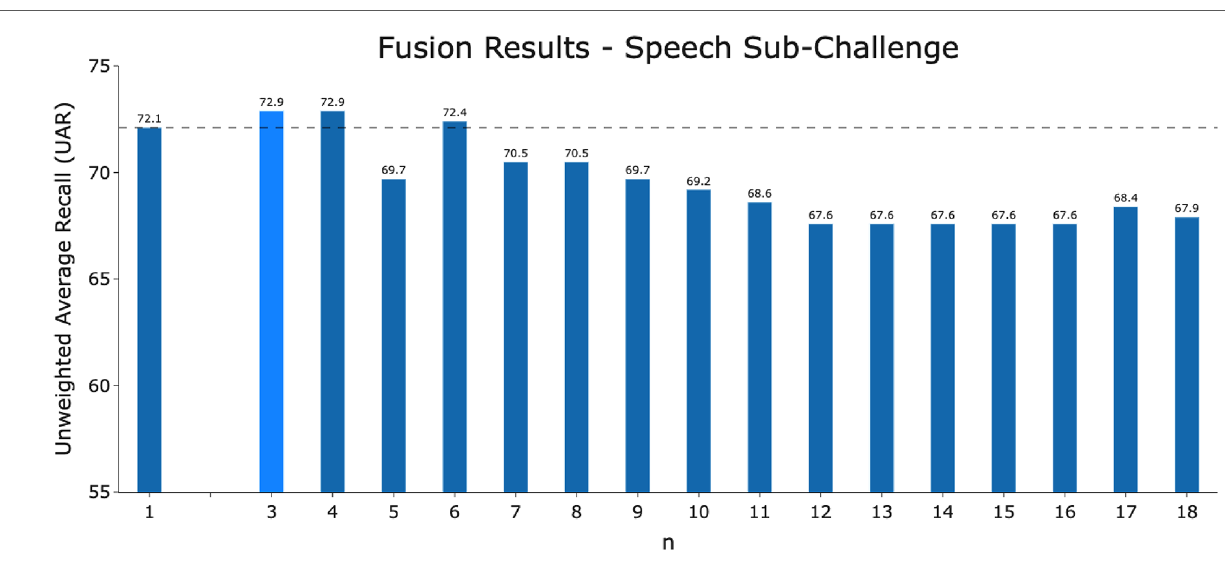
FIGURE A3 The performance of the fusion model of n -best models for the COVID-19 Speech Sub-Challenge using majority